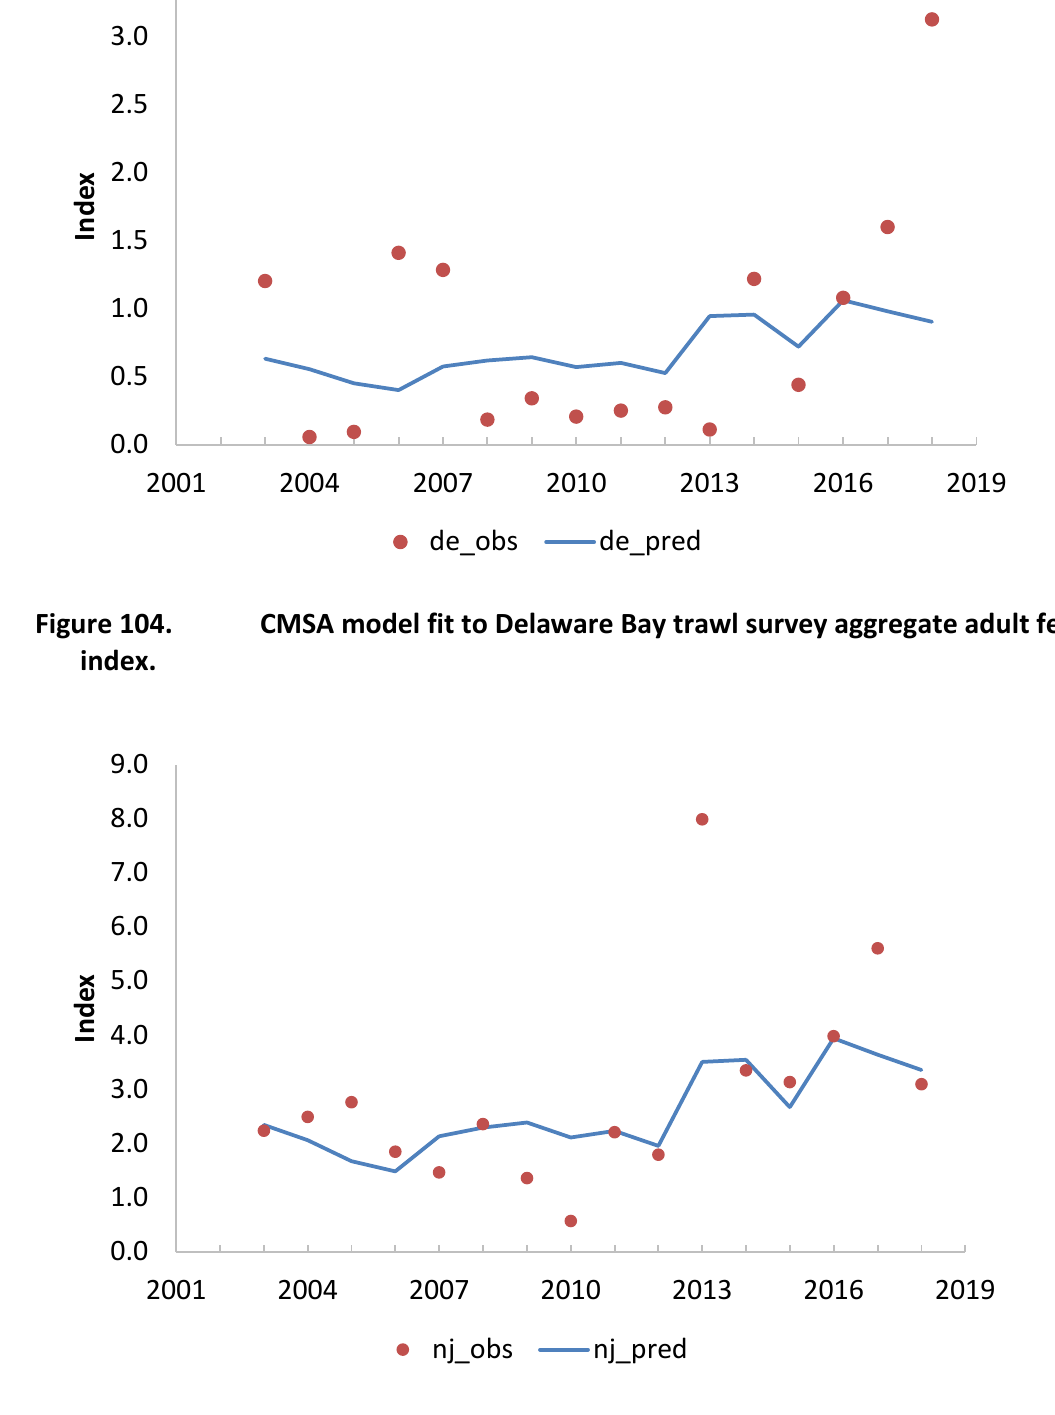
Figure 105. CMSA model fit to New Jersey Ocean trawl survey aggregate adult female